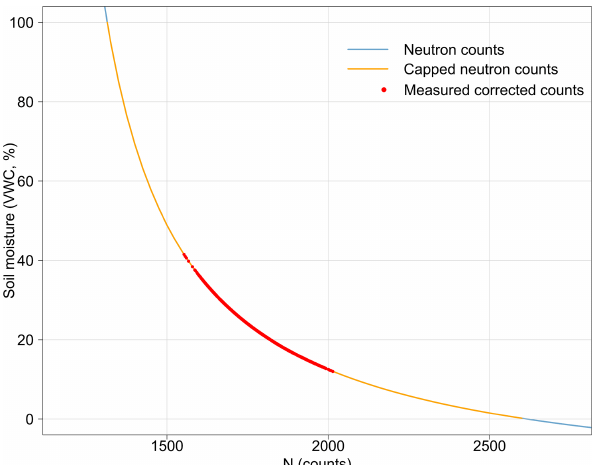
Figure 4. The calibration curve (Eq. 1) for determining soil mois- ture for the Redhill site. The range of neutron counts and the derived CRNS VWC are shown in blue. The range of possible capped neu- tron counts and VWC (determined by N min and N max ) is shown in orange. Corrected neutron counts and corresponding VWC at this site between 18 February 2016 and 8 February 2021 are shown in